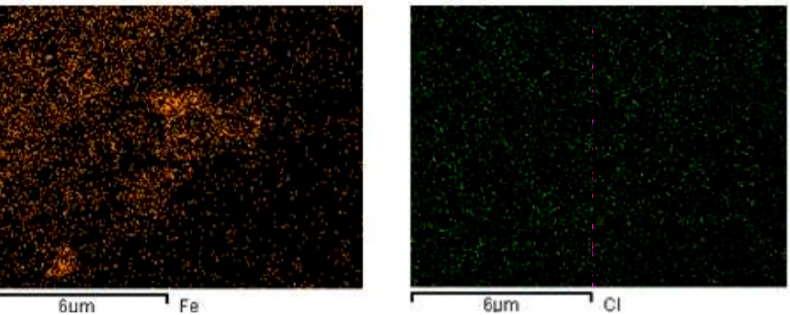
Figure 7. FTIR of the synthesized and modified activated carbon. The continuous line indicates the FTIR for the synthesized activated carbon (AC) material, whereas the dotted line refers to the FTIR for the activated carbon modified with 5.0 wt.% of magnetite nanoparticles (ACM) material.